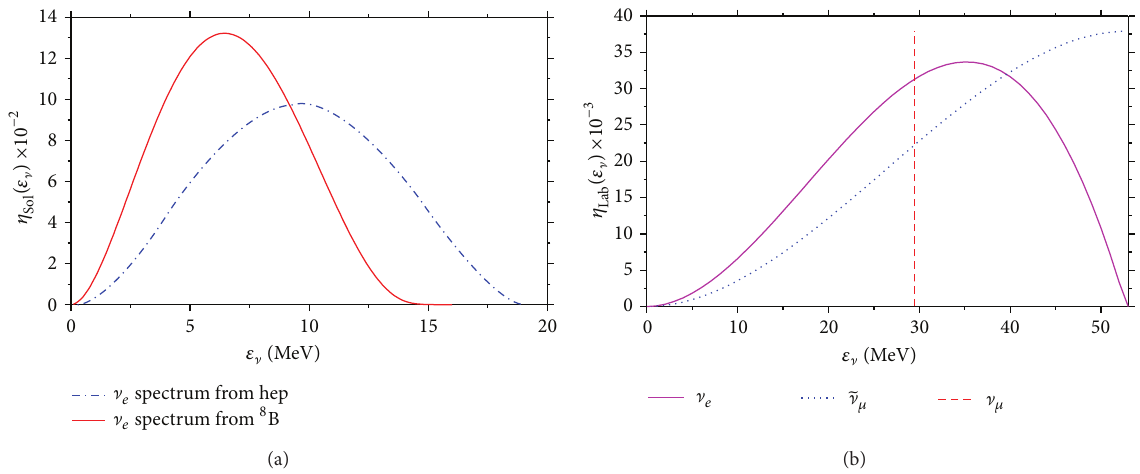
Figure 4: (a) Normalized energy spectrum of 8 B and hep ] 𝑒 solar neutrinos. (b) Energy spectra of ] 𝑒 and ̃ ] 𝜇 neutrino beams, generated from the muon-decay at